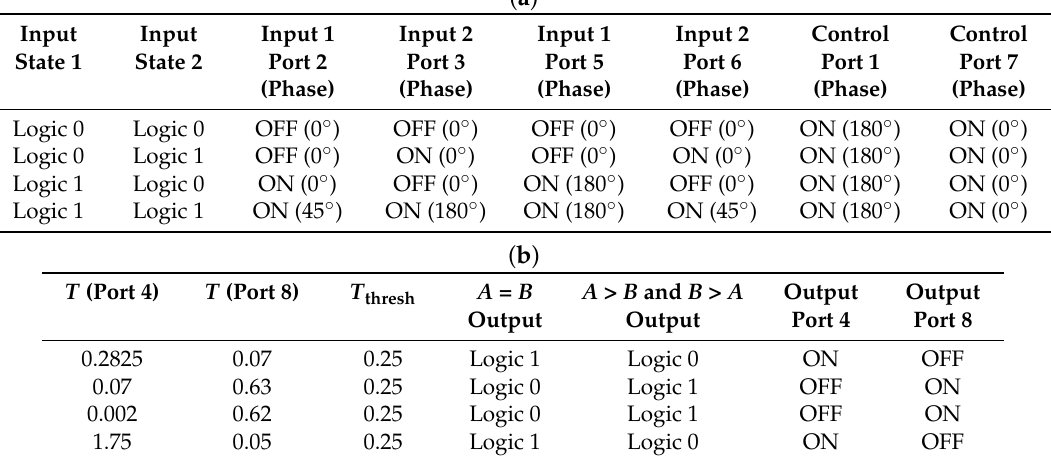
Table 3. Operation of the transmission for the proposed plasmonic comparator.